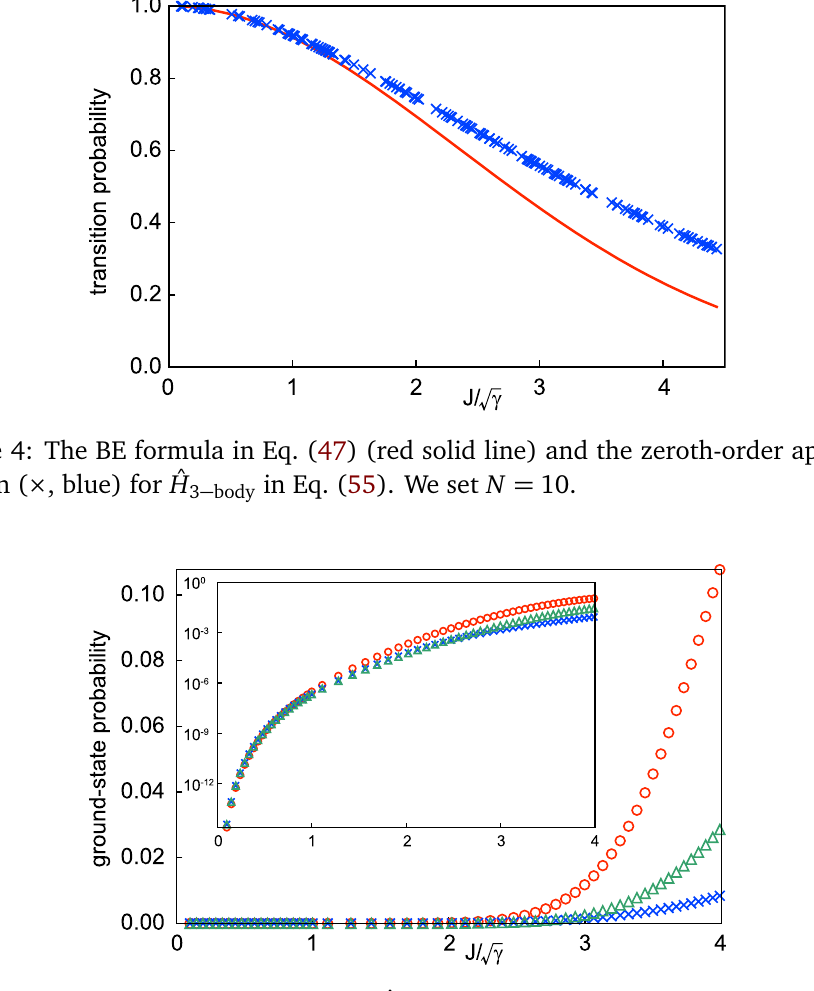
in Eq. (55) with N = 10. Legend is 3 − body